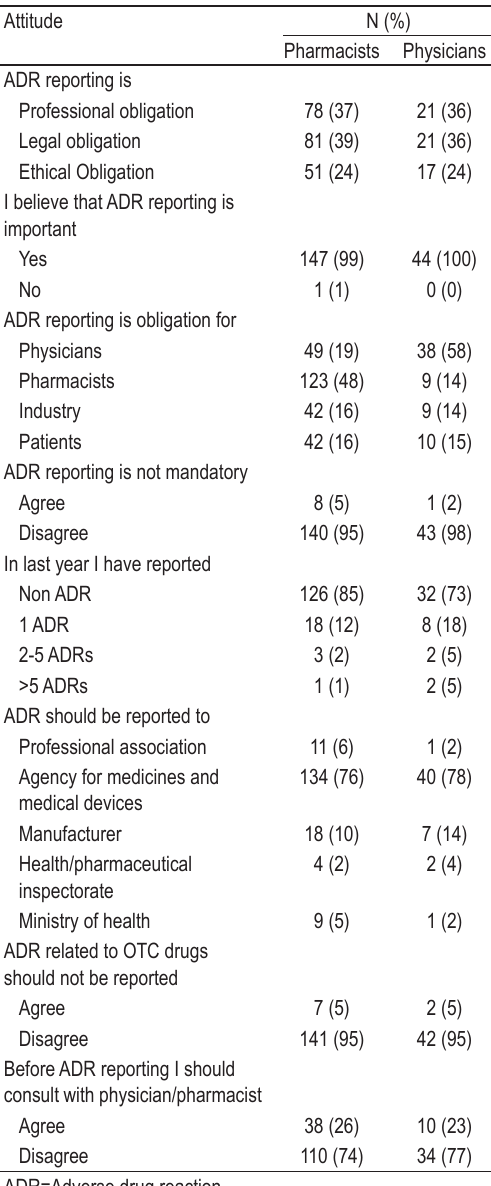
TABLE 2. Pharmacists’ and physicians’ attitudes to ADR